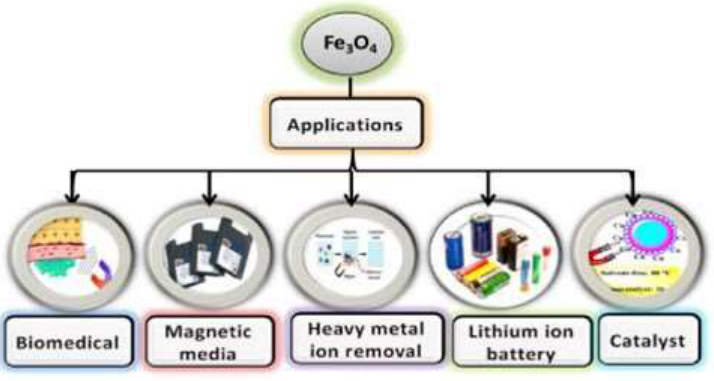
.sapplication 4 O 3 Fe The Schematic presentation of the Figure